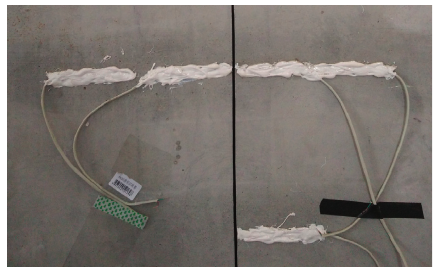
Figure 1: The defective shield tunnel segment.